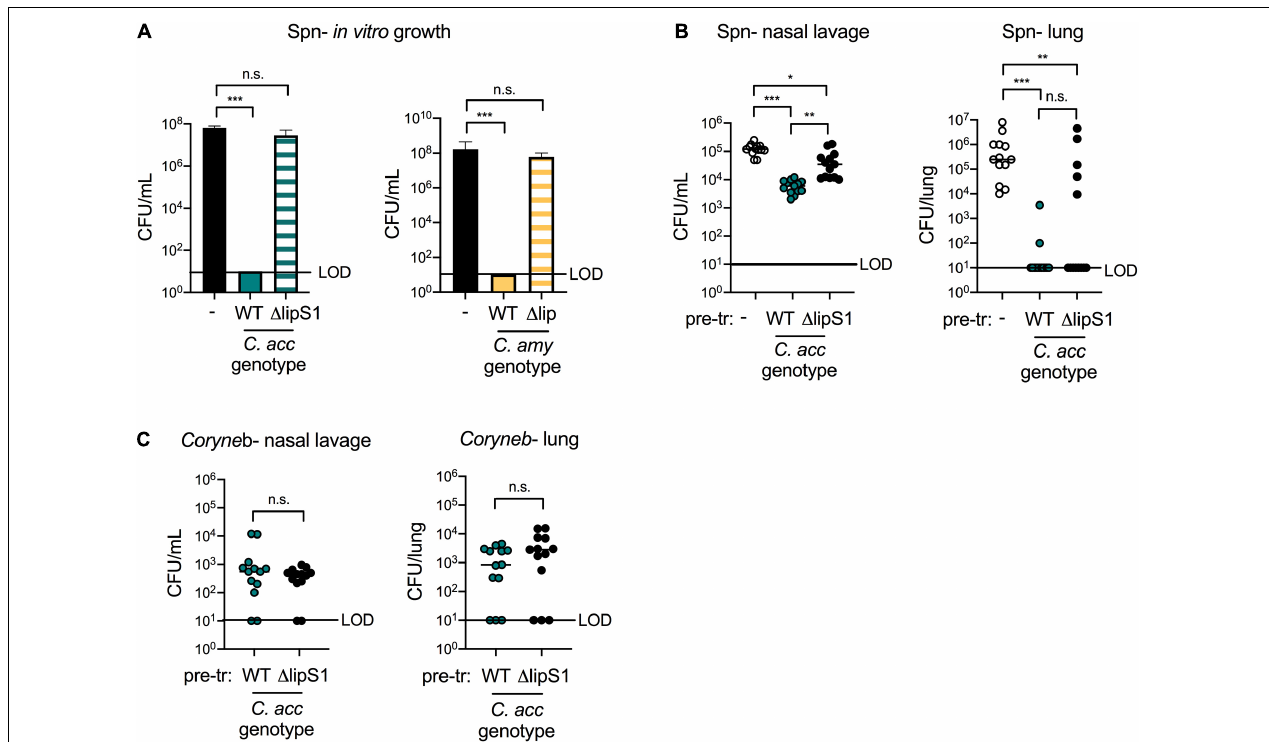
FIGURE 6 | Corynebacterium lipases contribute to, but are not required for, protection against S. pneumoniae in vivo. Growth of type 2 S. pneumoniae (Spn) on untreated plates (–) or on plates pre-treated with supernatants from WT vs. (cid:49) lipS1 C. acc or WT vs. (cid:49) lip C. amy grown in BHI with 1% Tween 80 and 180 mg/mL triolein (A) . Burden of Spn (B) or Corynebacterium ( Coryneb ) (C) in nasal lavage fluid and lungs of mice pre-exposed to PBS (–), WT C. acc or (cid:49) lipS1 C. acc at 24 h post-Spn infection detected by live growth. Limit of detection (LOD) is indicated. Data are pooled from three independent experiments with 3–5 mice per group. * p < 0.05, ** p < 0.01, *** p < 0.001, ANOVA (A) or Kruskal-Wallis test (B,C)